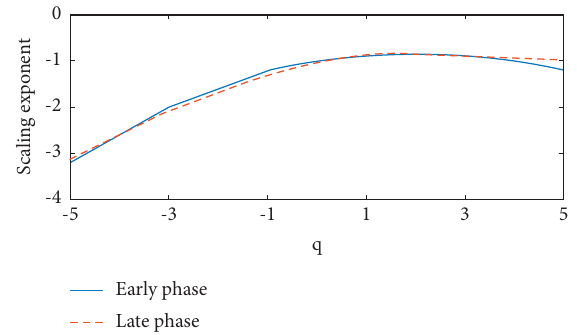
Figure 25: Early and late scaling exponents.